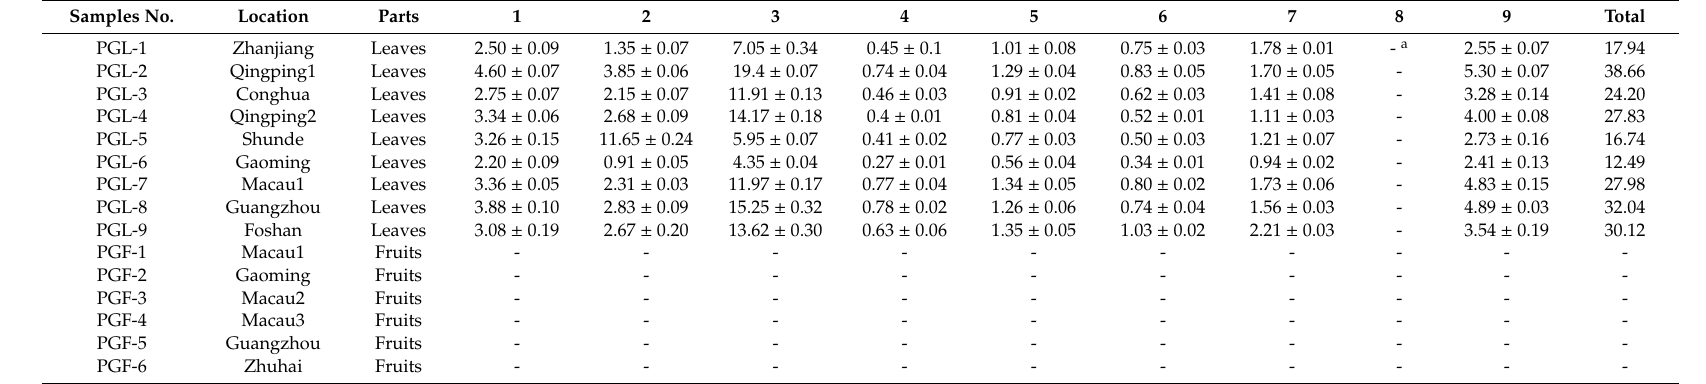
Table 5. Contents (mg / g) of nine triterpenoids in fifteen P. guajava